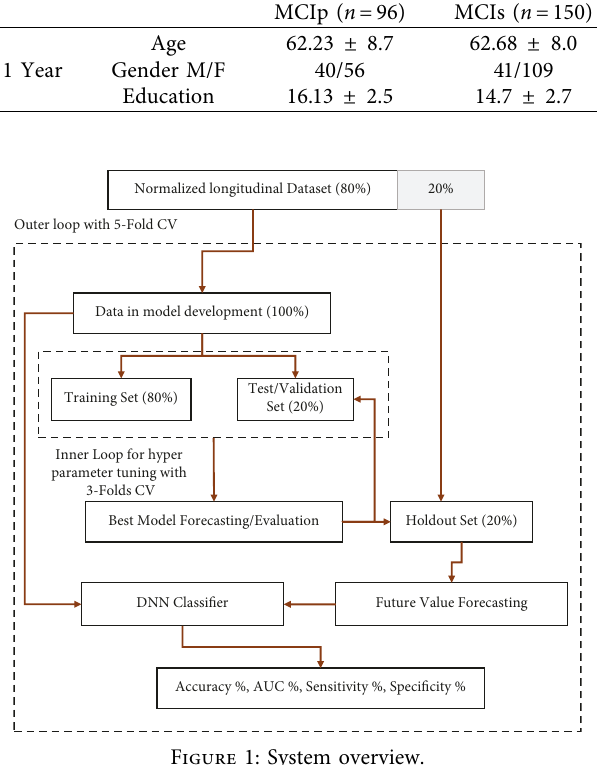
Figure 1: System